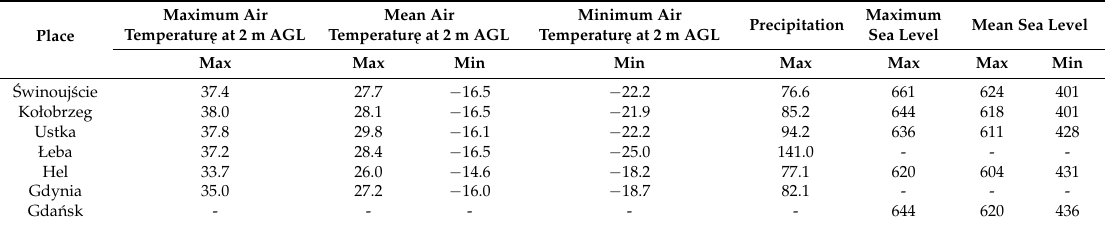
Table 1. Absolute extremes of air temperature ( ◦ C), atmospheric precipitation (mm), and sea level (cm) in the Polish coastal zone of the South Baltic (1965–2014). AGL: About ground